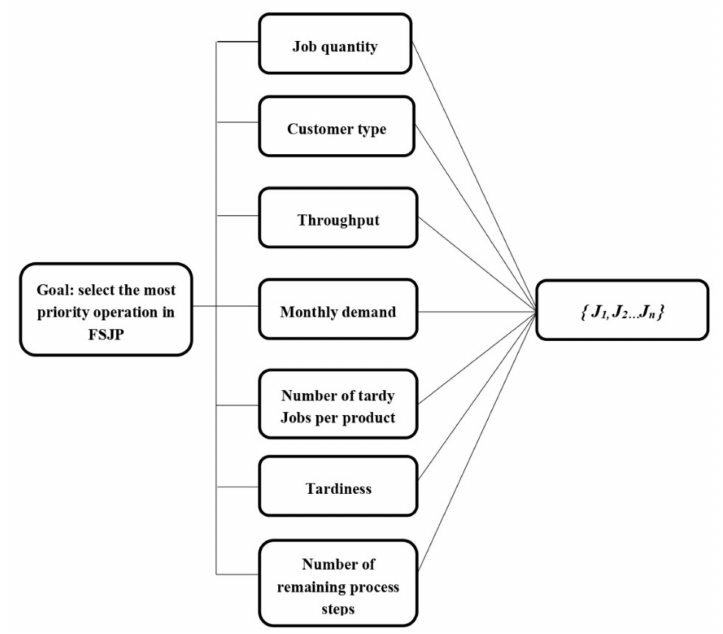
Figure 7. The operation prioritization